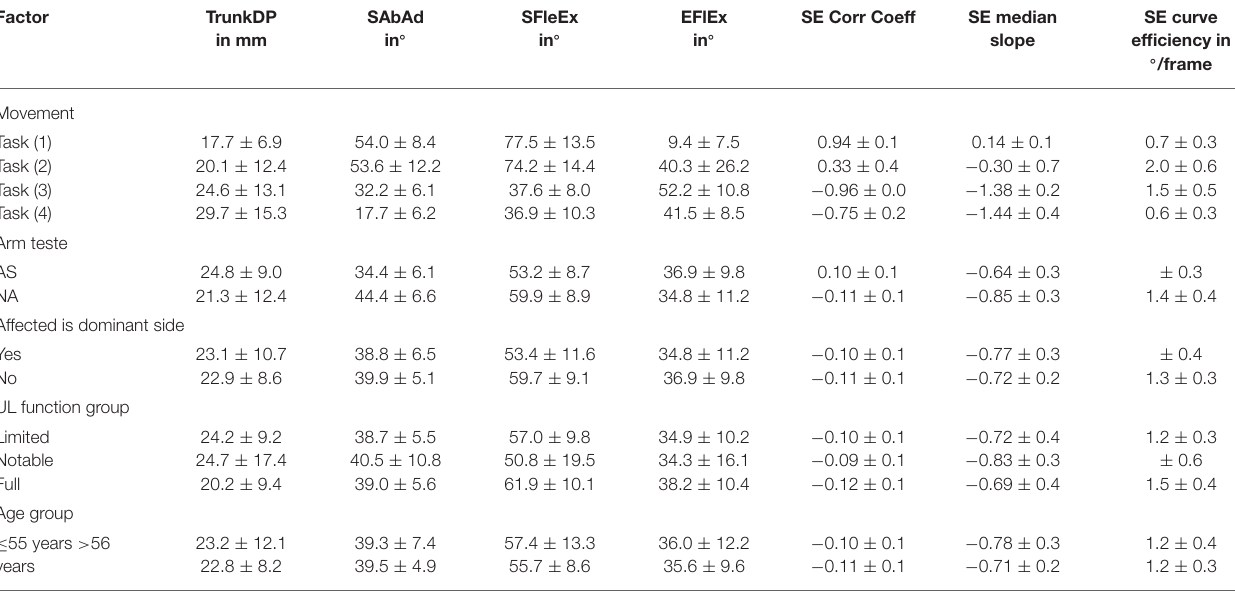
TABLE 3 | Descriptive statistics for each kinematic parameter per task and tested arm. Factor TrunkDP